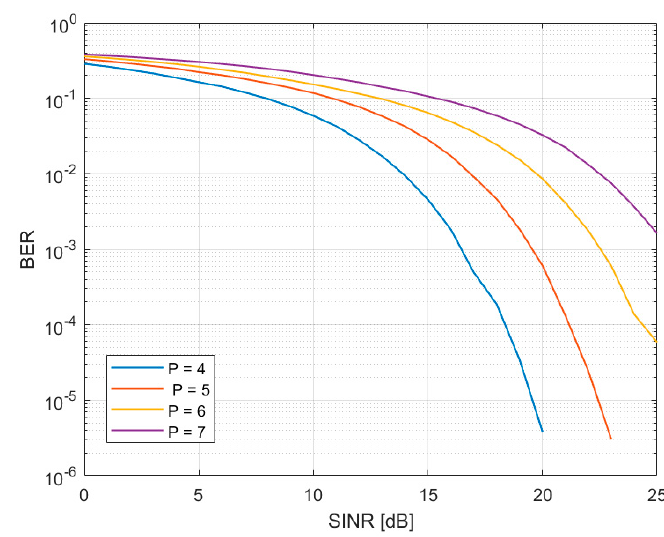
Figure 2. BER evolution considering different SINR ratios and p values in OFDMA.